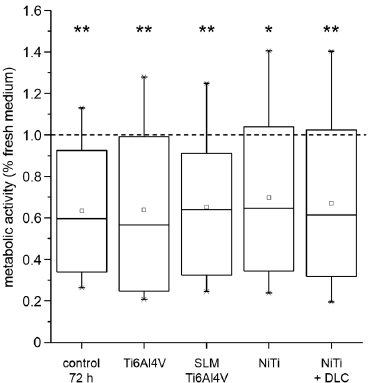
Figure 3. Metabolic activity of human osteoblasts ( n = 4) cultured in pre-incubated (72 h) cell culture medium and incubated supernatants (72 h) of different test pellets (forged Ti6Al4V, Ti6Al4V SLM, NiTi, and NiTi + DLC) compared to fresh medium as reference (dotted line). Boxes denote interquartile ranges, horizontal lines within the boxes denote medians, and whiskers denote minimum and maximum values. For statistical analysis, ANOVA was conducted. Data were compared to the fresh medium control (100%, * p ). * p < 0.05, ** p < 0.01.